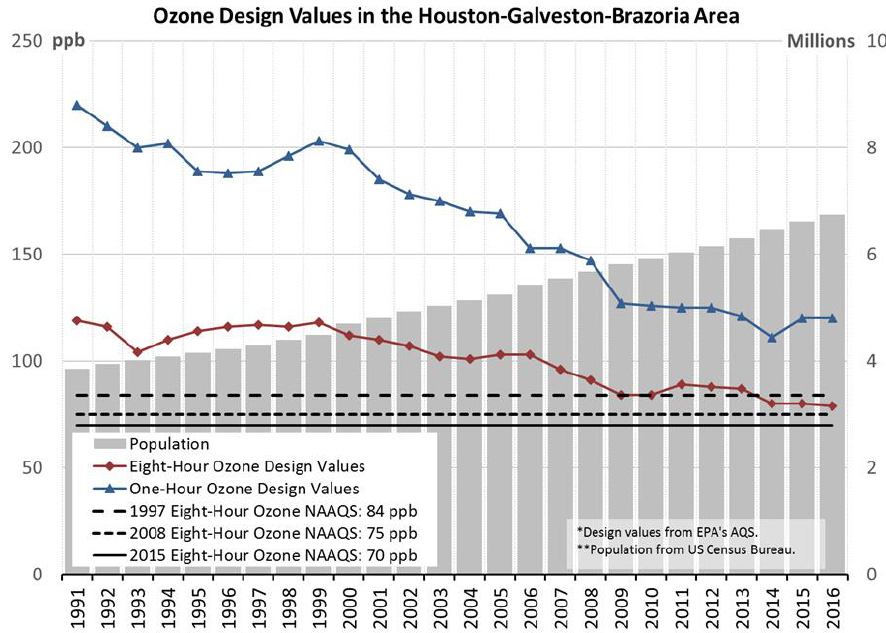
Figure 4. Ozone regulatory design values in the Houston-Galveston-Brazoria area of Texas from 1991 to 2016. Ozone design values are regulatory values that comprise the annual fourth-highest daily maximum 8-h ozone concentration, averaged over 3 years (eight-hour ozone design values), or the maximum hourly average concentration (one-hour ozone design values). Texas Ozone Data: http://www.tceq.texas.gov/airquality/airsuccess/airSuccessCriteria.